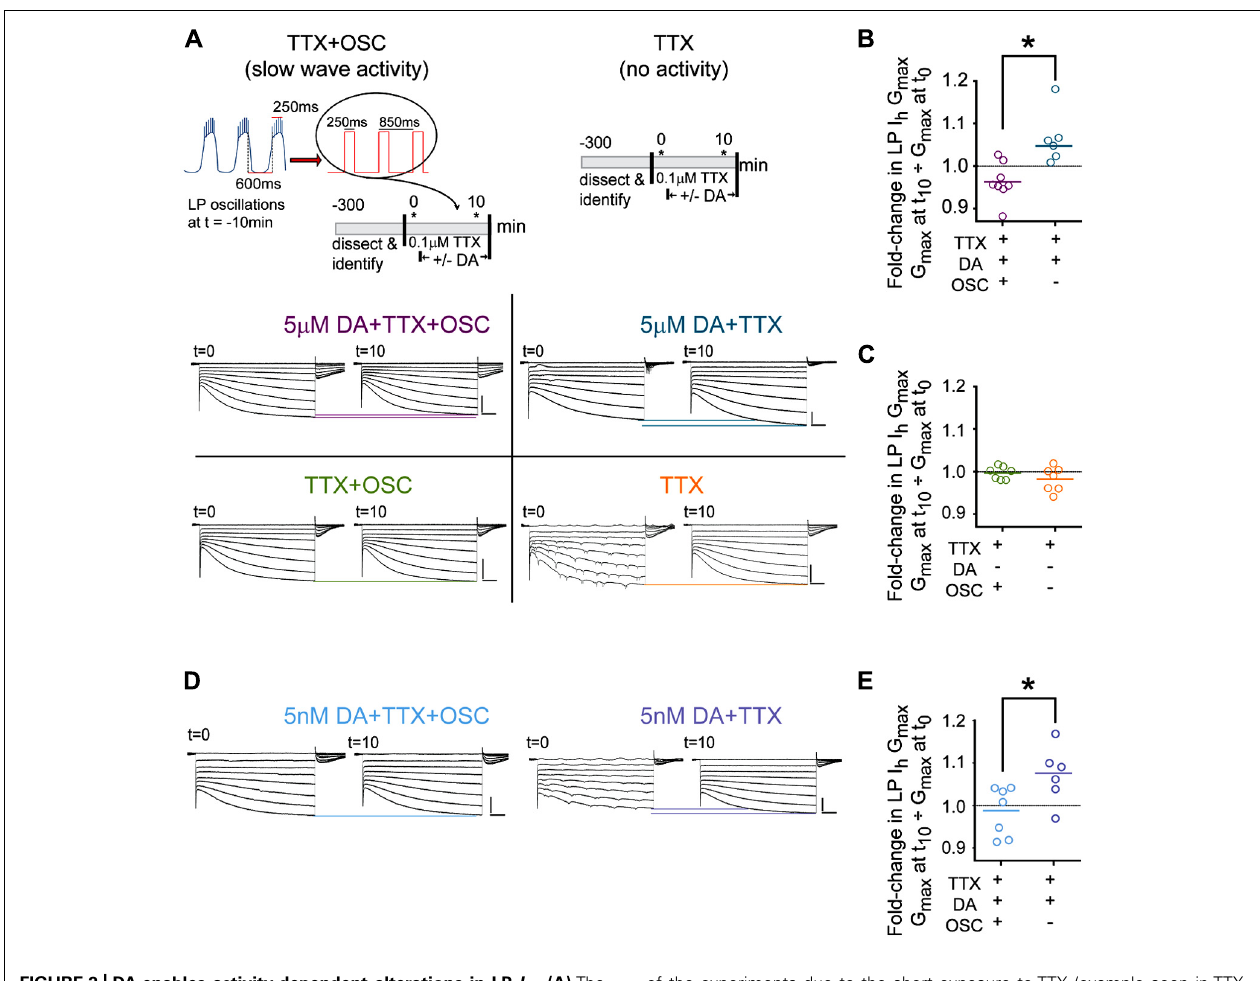
of the experiments due to the short exposure to TTX (example seen in TTX group); nevertheless, I h could be measured from the traces. (B,C) Plots of the fold-changes in LP I h G max in each treatment group at t = 10 min. Each symbol represents one experiment; solid lines indicate the means; * p < 0.05, t -tests. (D) Typical LP I h recordings for additional experiments in 5 nM DA. (E) Plots of the fold-changes in LP I h G max in each treatment group in 5 nM DA at t = 10 min. Each symbol represents one experiment; solid lines represent means * p < 0.05, t